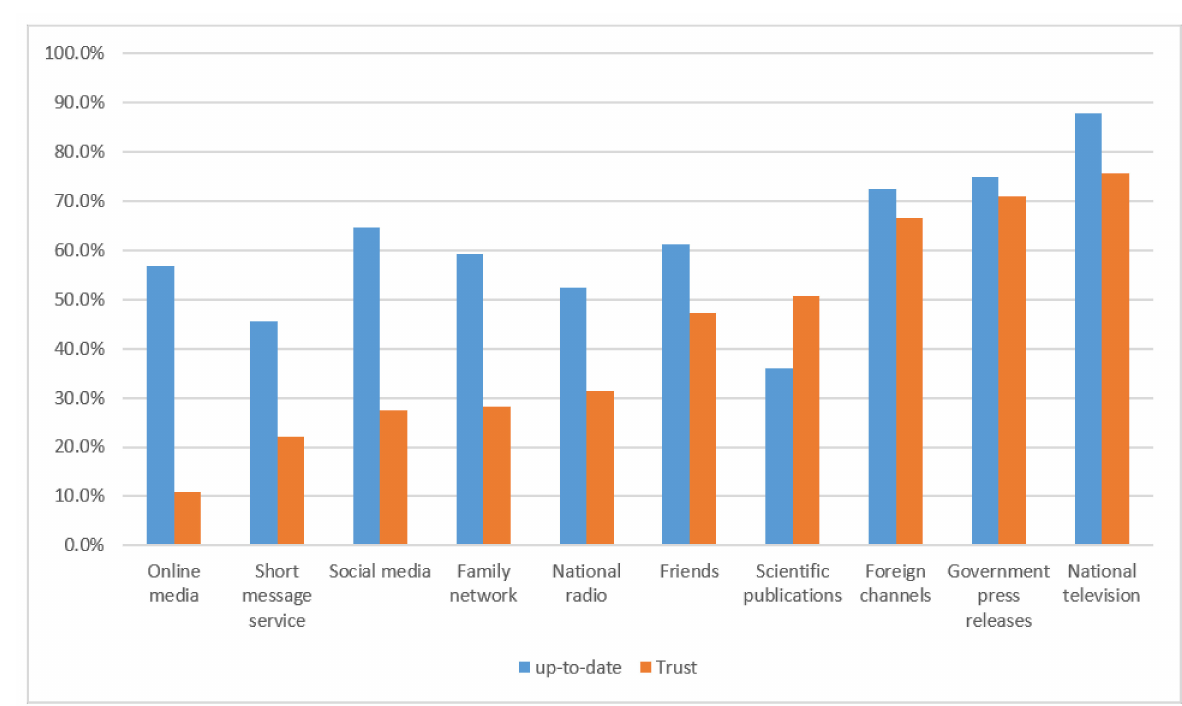
Figure 2. Respondents’ sources of information to stay up-to-date on the COVID-19 epidemic and their trust in these sources. The study was conducted from 26 April to 16 May 2020 in C ô te